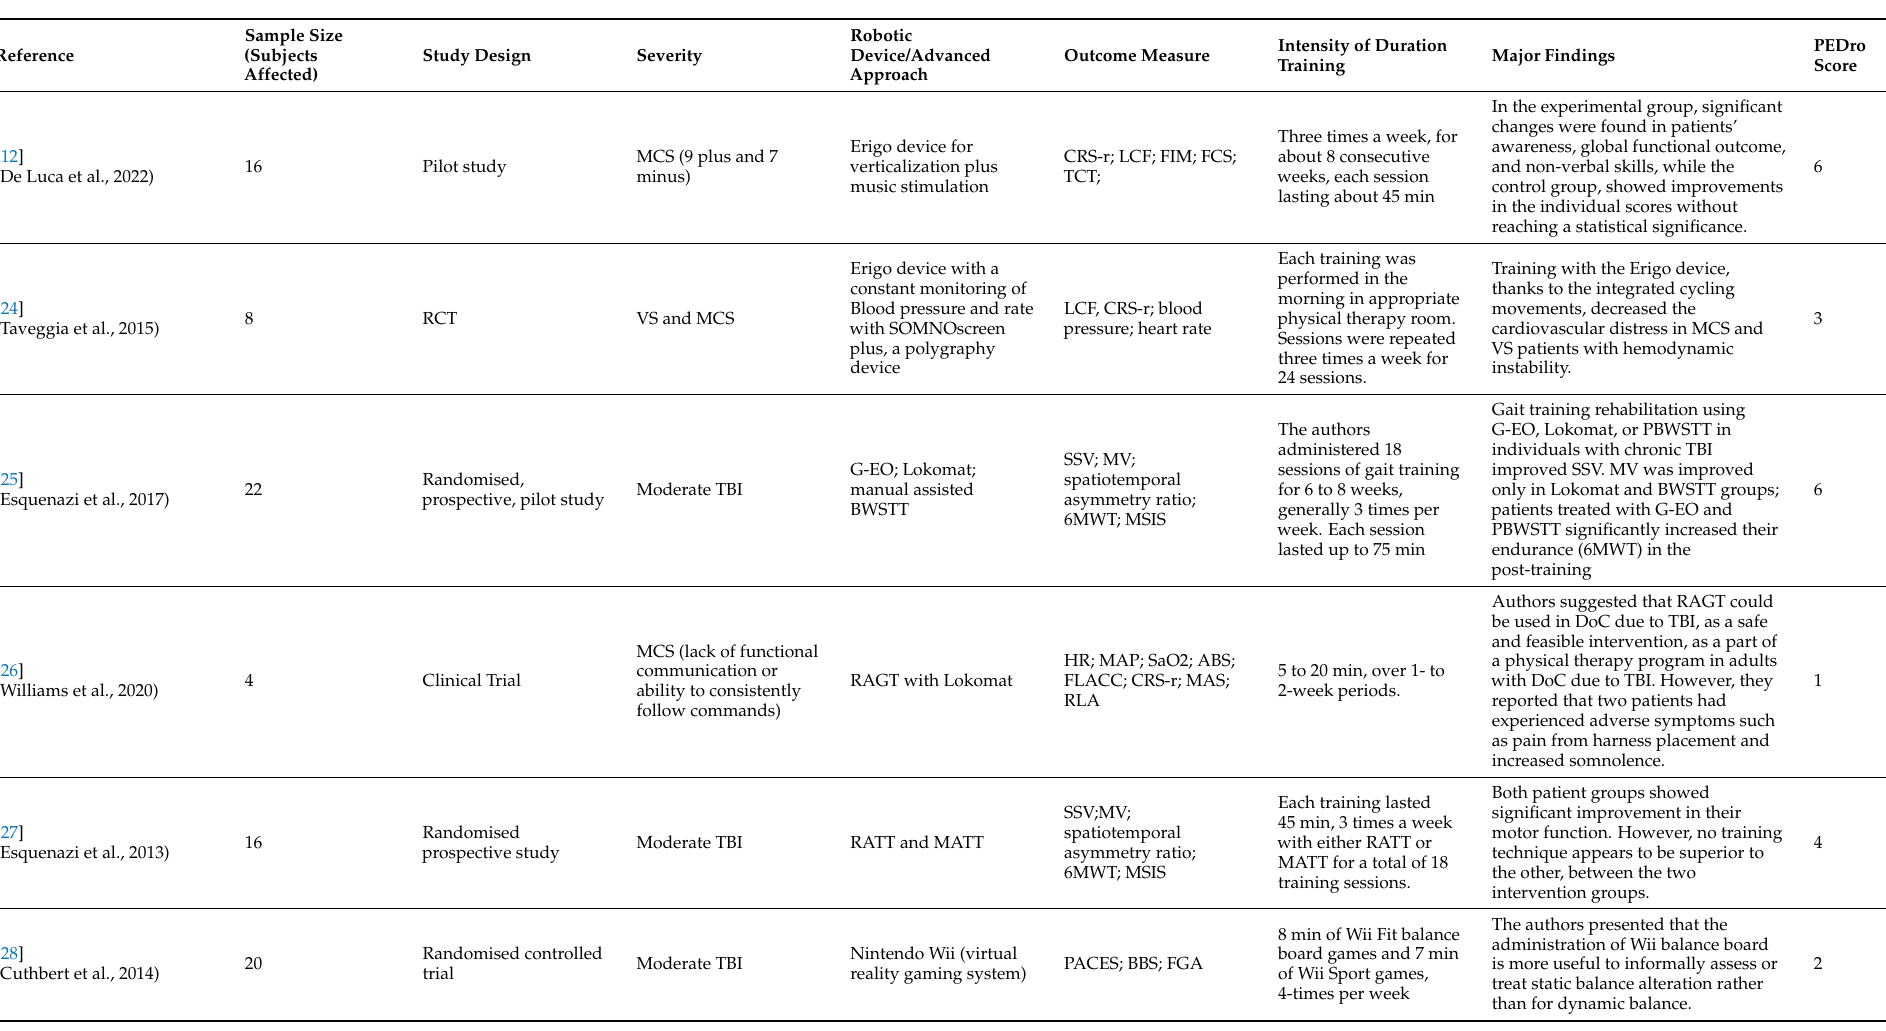
Table 1. Robotics and technologies used in TBI